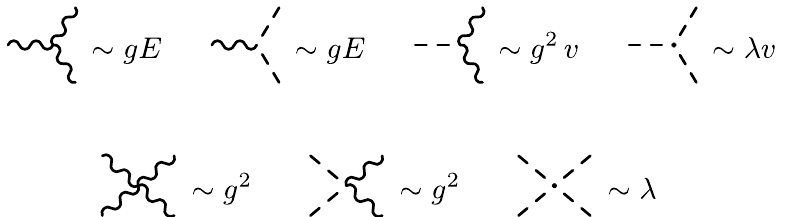
Figure 5: Coupling and energy power-counting of the vertices relevant to tree level WW scattering. Factors of sines and cosines of the weak angle are treated as numbers of order unity for simplicity. They could be straightforwardly included allowing us, for instance, to exploit the mild hierarchy between g and g (cid:48)